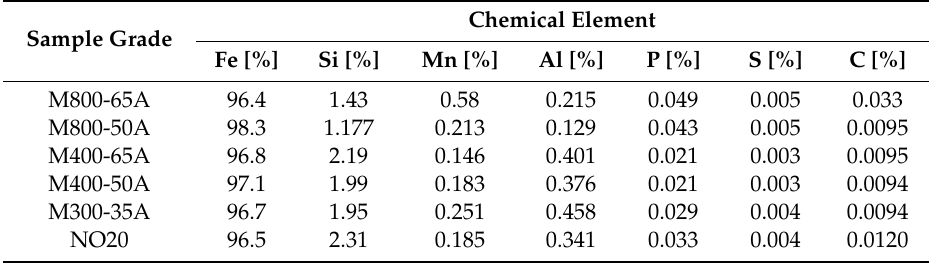
Table 2. Chemical composition of non-oriented electrical